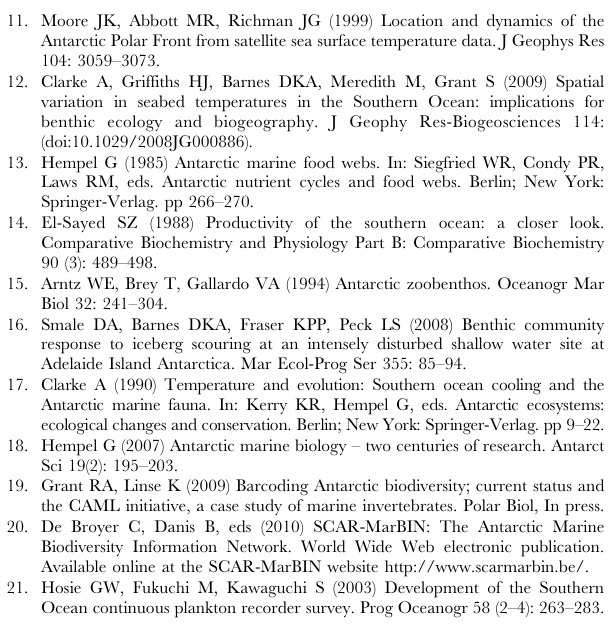
Table S1 Detailed taxonomic expertise within the Antarctic study area, and estimated numbers of described and undescribed species per taxon. State of Knowledge 5= very well-known ( . 80% described, ID guides , 20 years old, and current taxonomic expertise); 4= well-known ( . 70% described, ID guides , 50 years old, some taxonomic expertise), 3 =poorly known ( , 50% species described, ID guides old or incomplete, no present expertise within region), 2= very poorly known (only few species recorded, no ID guides, no expertise), 1= unknown (no species recorded, no ID guides, no expertise)